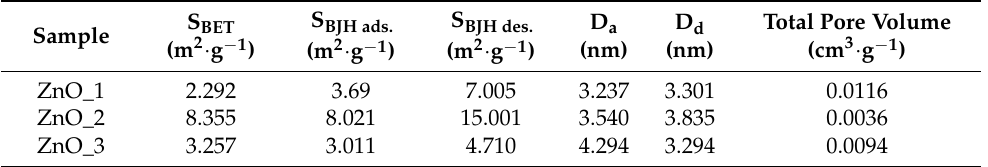
Table 3. Textural properties of the calcinated ZnO samples.